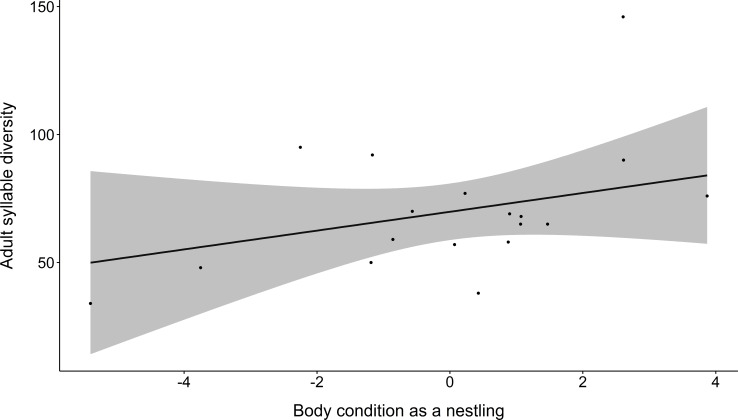
The relationship between nestling body condition and syllable diversity in adult song.The line shows the predicted relationship from averaging of the best fitting general linear models; the raw data are plotted as points. The 95% confidence interval is shown in grey.